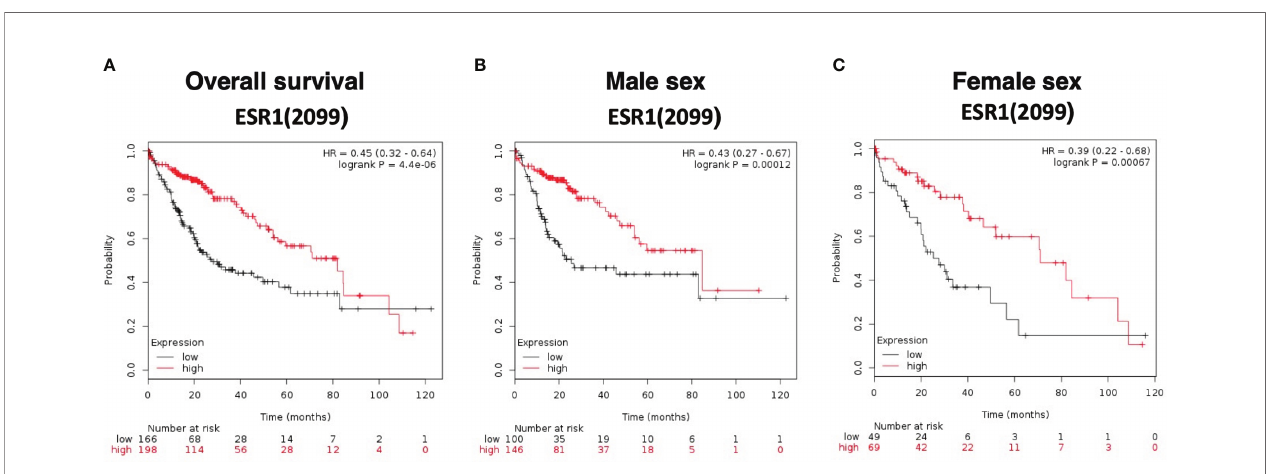
FIGURE 5 | Survival curves based on expression of ESR1 (RNAseq ID 2099) in the TCGA dataset. (A) Overall survival according to ESR1 status based on auto selected best cutoff value (79). (B) Survival according to ESR1 status and further strati fi ed by Male sex, based on auto selected best cutoff value (79) (C) Survival according to ESR1 status and further strati fi ed by Female sex based on auto selected best cutoff value (43). Separation of patients by ESR1 expression in Kaplan- Meier plotter was based on the best cutoff computed from all the possible cutoff values between the lower and upper quartile